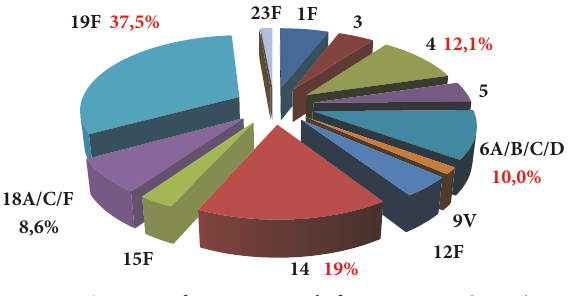
Figure 2: Spectrum of serovariants of S. pneumoniae in carriers before vaccination with PCV-13 (Khabarovsk Territory, 2014, %).